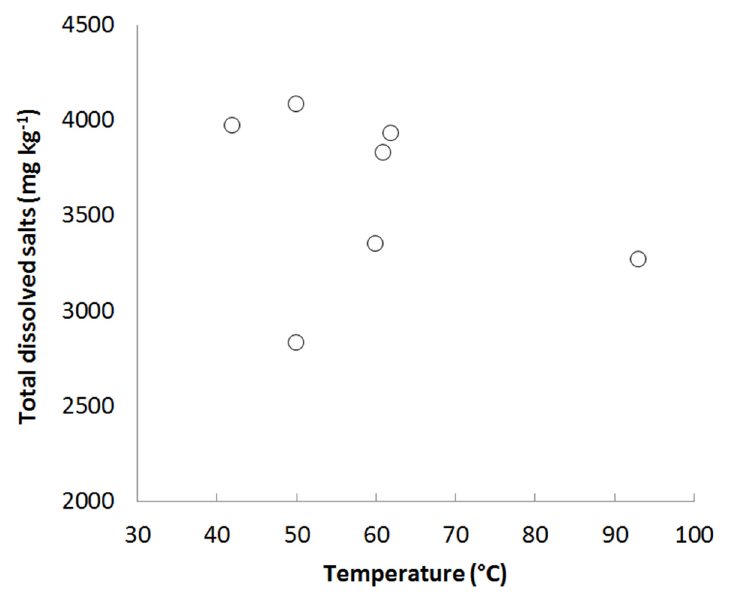
Figure 7. Temperatures and salinities of the thermal springs in the Tuwa area of Gujarat